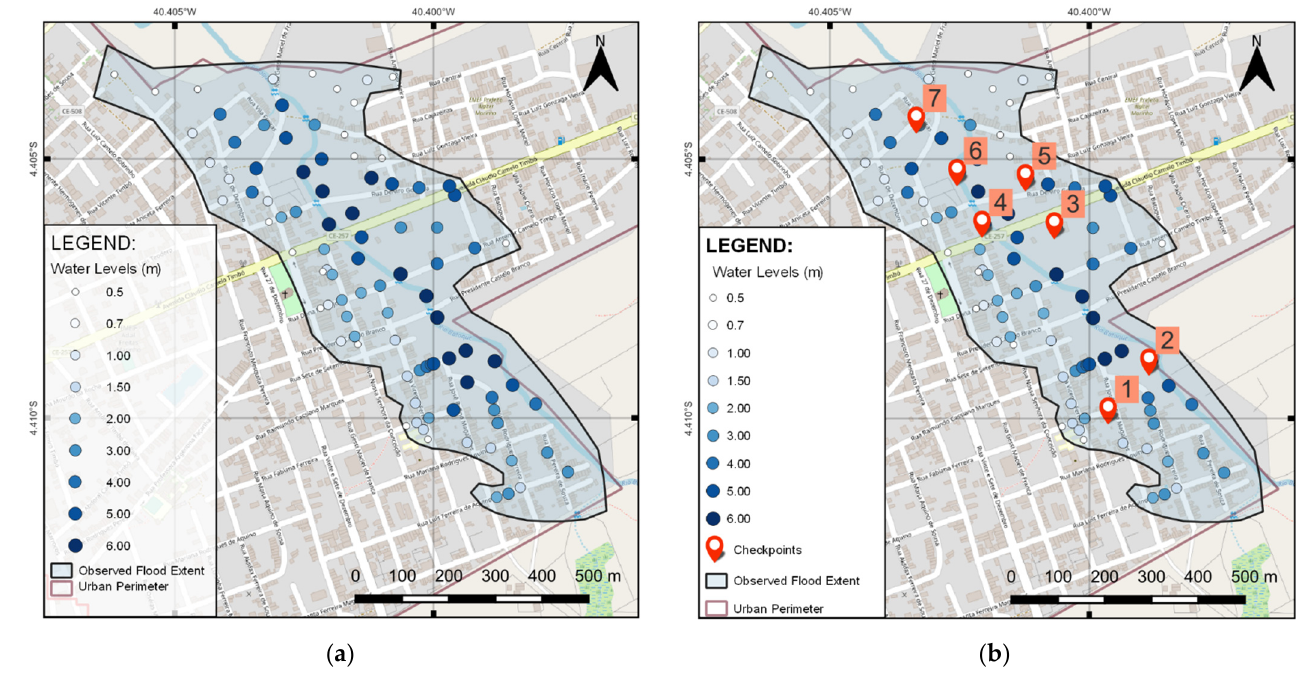
Figure 8. ( a ) Observed floodplain. ( b ) Checkpoints for the validation.